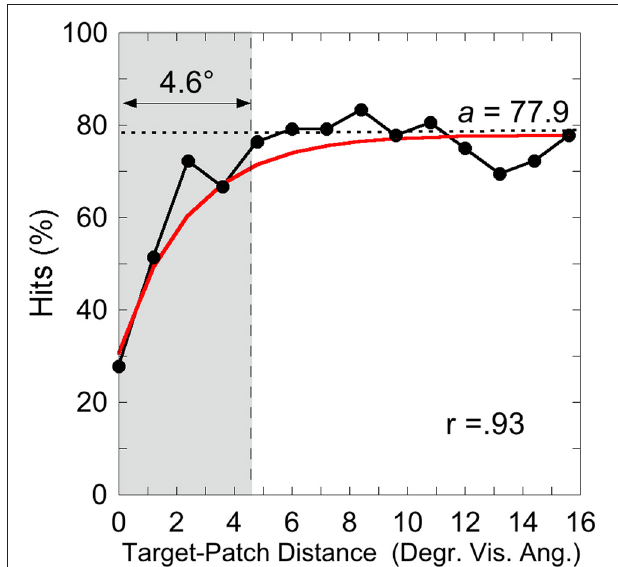
FIGURE 4 | Experiment 1: hits by Participant SL as a function of target-patch distance converging to the value a (dotted line). The gray field represents the critical distance (90% from a ). The inverse exponential function fits the data well ( r = 0 . 93).